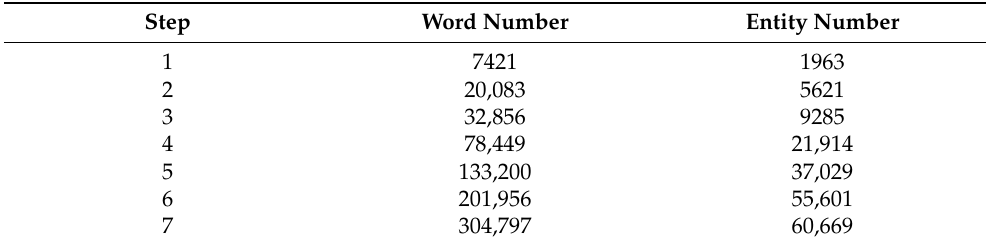
Table 2. Number of words and annotated entities in each step of the iterative AL annotation proce-